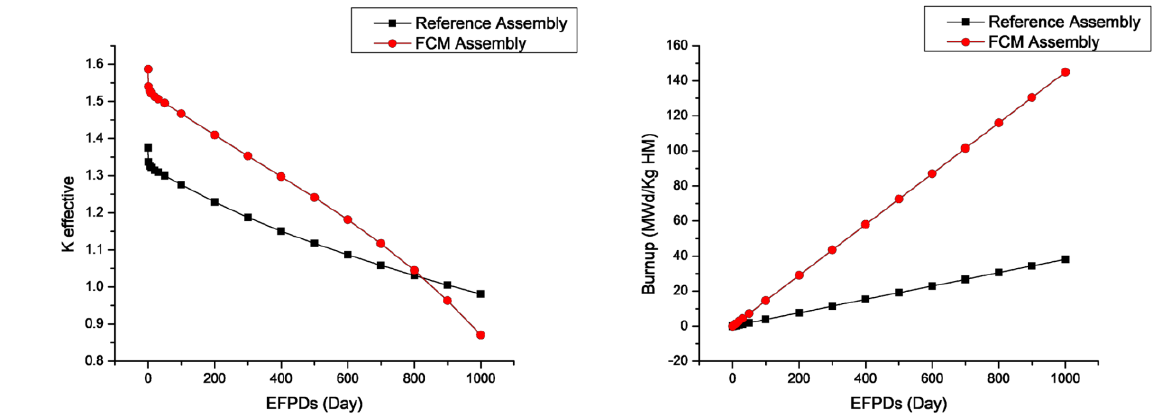
Figure 4. Burnup Analysis of Reference and FCM assemblies.